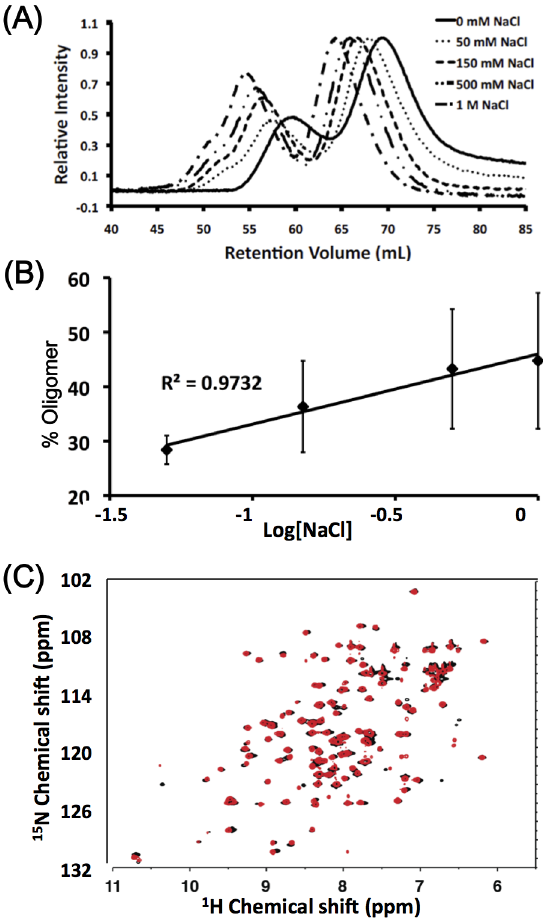
Figure 3. Increasing salt concentration leads to increased CTD Q290C self-association. (A) Chromatogram of CTD Q290C under different salt concentrations. The systematic shift is caused by nonspecific interaction of the protein with the Superdex column matrix in the absence of salt. (B) Oligomer percentage increases with increasing salt concentration in a semi-log manner. Data points ( ¤ ) and error bars represent the average and standard error of three independent experiments. (C) Overlay of 15 N-edited HSQC spectra of CTD Q290C in 50 mM NaCl (black) and 500 mM NaCl (red). Resonance patterns between the two are virtually identical, indicating that no structural changes occur at different salt concentrations.